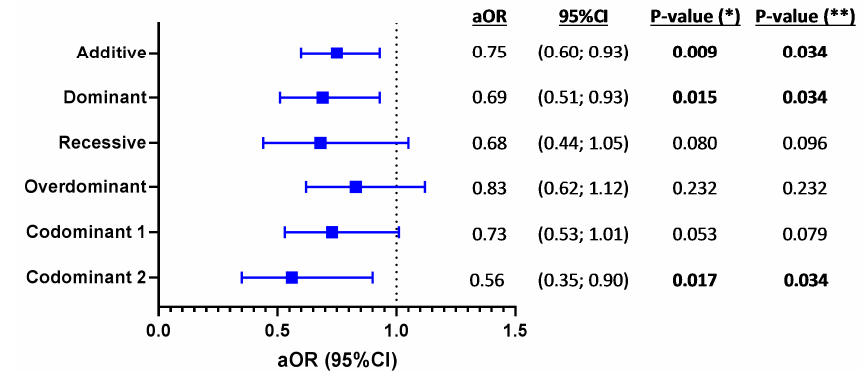
Figure 3. Genetic association of VDR rs2228570 polymorphisms with patterns of AIDS progression (ordinal variable) in HIV infected patients. p -values were calculated by ordinal regression adjusted for age, gender, and risk category (men who have sex with men (MSM) versus others). (*), raw p -values; (**), p -values corrected for multiple testing using the false discovery rate (FDR) with Benjamini and Hochberg procedure ( n = 6, multiple comparisons). VDR, vitamin D receptor; LTNPs, Long Term Non Progressors; MPs, Moderate Progressor; RPs, Rapid Progressor; Codominant 1, codominant 1 refers to heterozygous genotype vs more frequent homozygous (genotype 1); Codominant 2, codominant 2 refers to less frequent homozygote (genotype 2) vs more frequent homozygote (genotype 1).